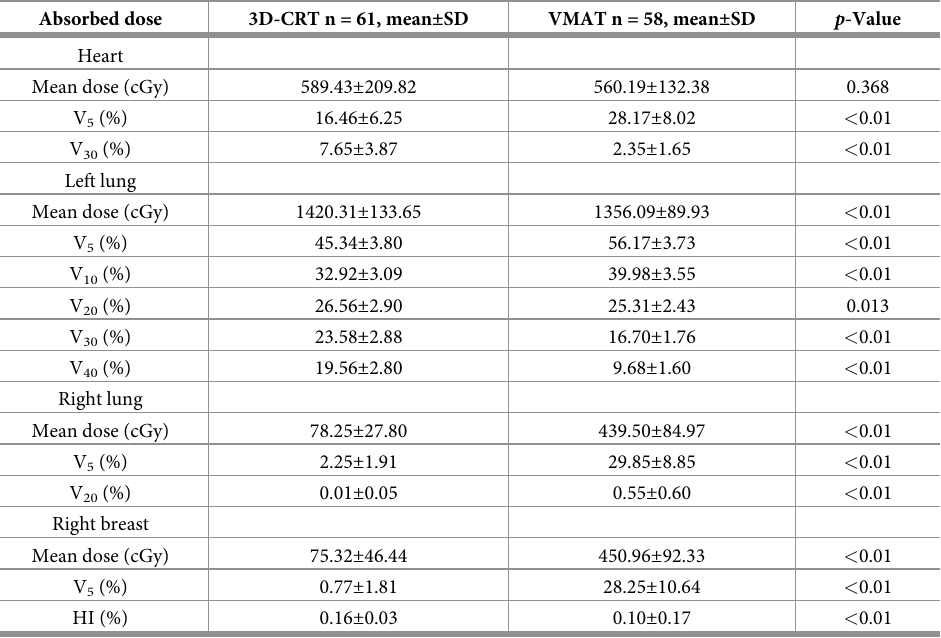
Table 2. Dosimetric parameters of OARs.